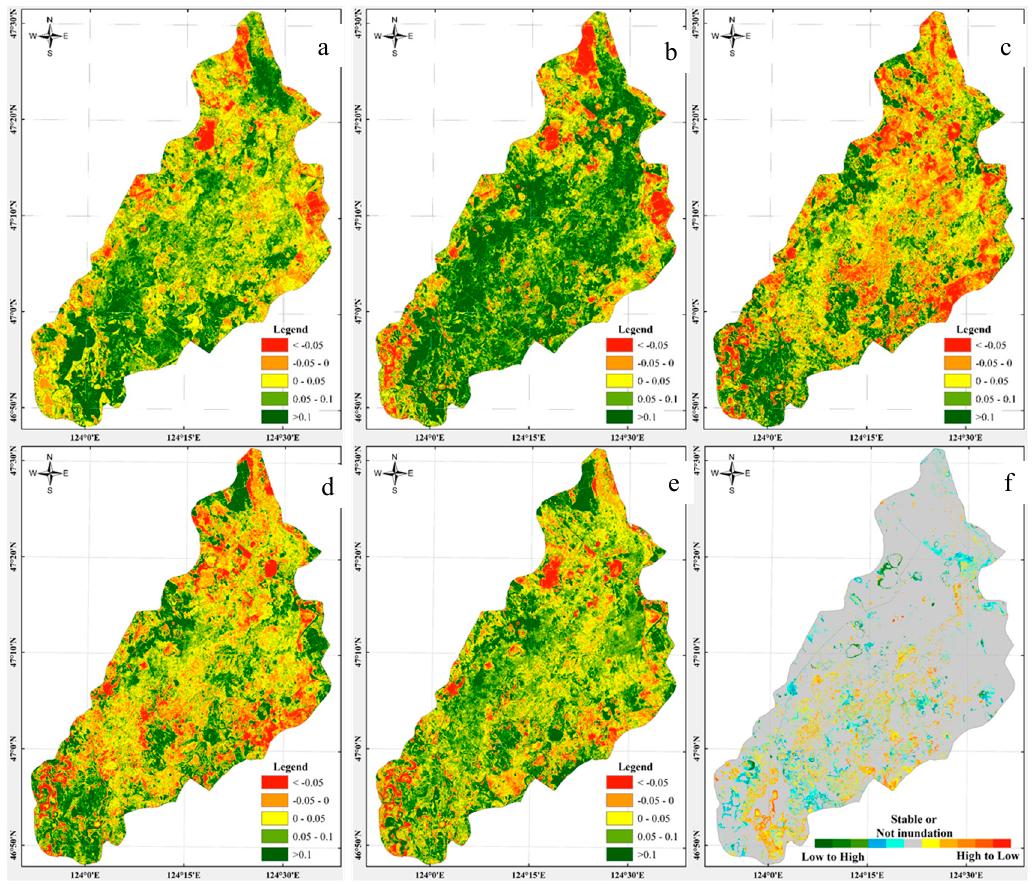
Figure 6. Spatial distribution of vegetation growth from May to September ( a–e ). ( f ) The inundation frequency transformation from the pre- to post-ecological water replenishment period.